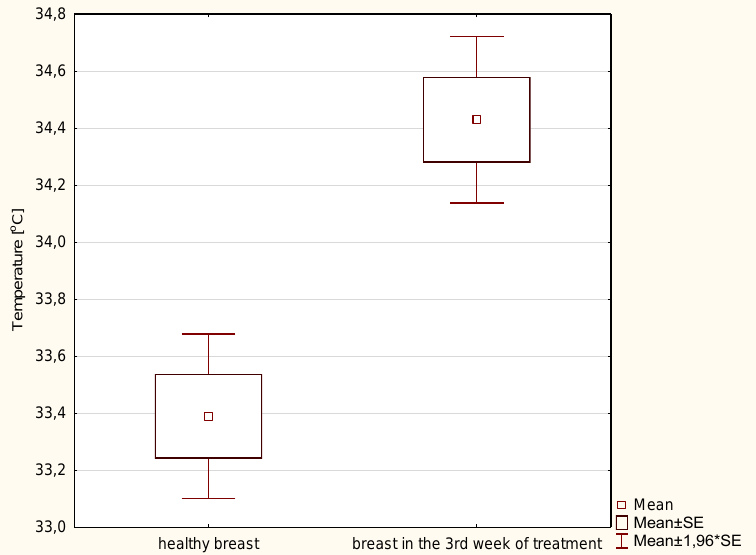
Figure 5. Average temperatures in the third week of treatment in the PTV area and for a healthy breast.